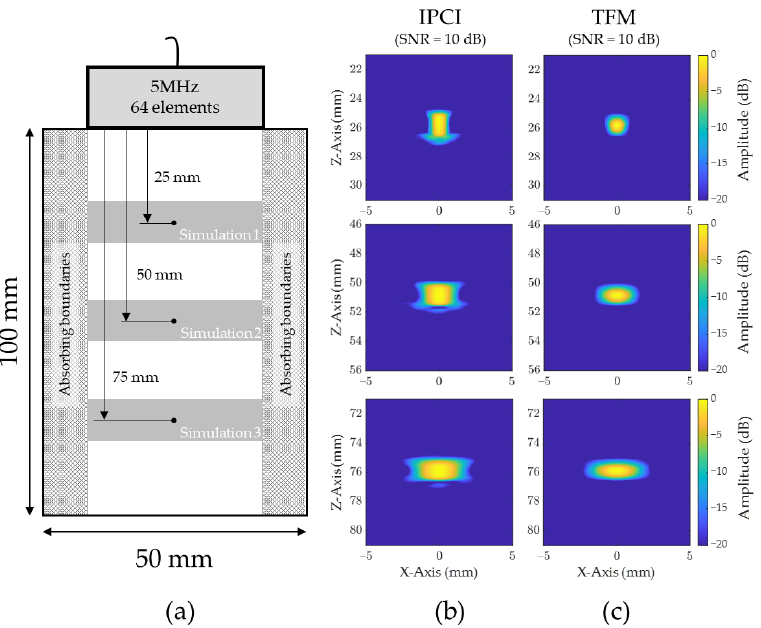
Figure 6. Simulated noise level sensitivity analysis principle for a point like scatterer, using both IPCI and conventional TFM: ( a ) simulation setup showing the 3 different simulations that were conducted, modeling a 5 MHz, 64 element probes and 0.4 mm diameter side drilled holes; ( b ) images obtained for each scatterer, and each simulation using IPCI and an added band-limited Gaussian noise with a SNR of 10 dB; ( c ) images obtained for each scatterer, and each simulation using TFM and an added 10 dB Gaussian noise. Table 1. Noise level sensitivity analysis results for a point like scatterer using both IPCI and conventional TFM algorithms where array performance indicator (API) was computed for each simulated configuration.